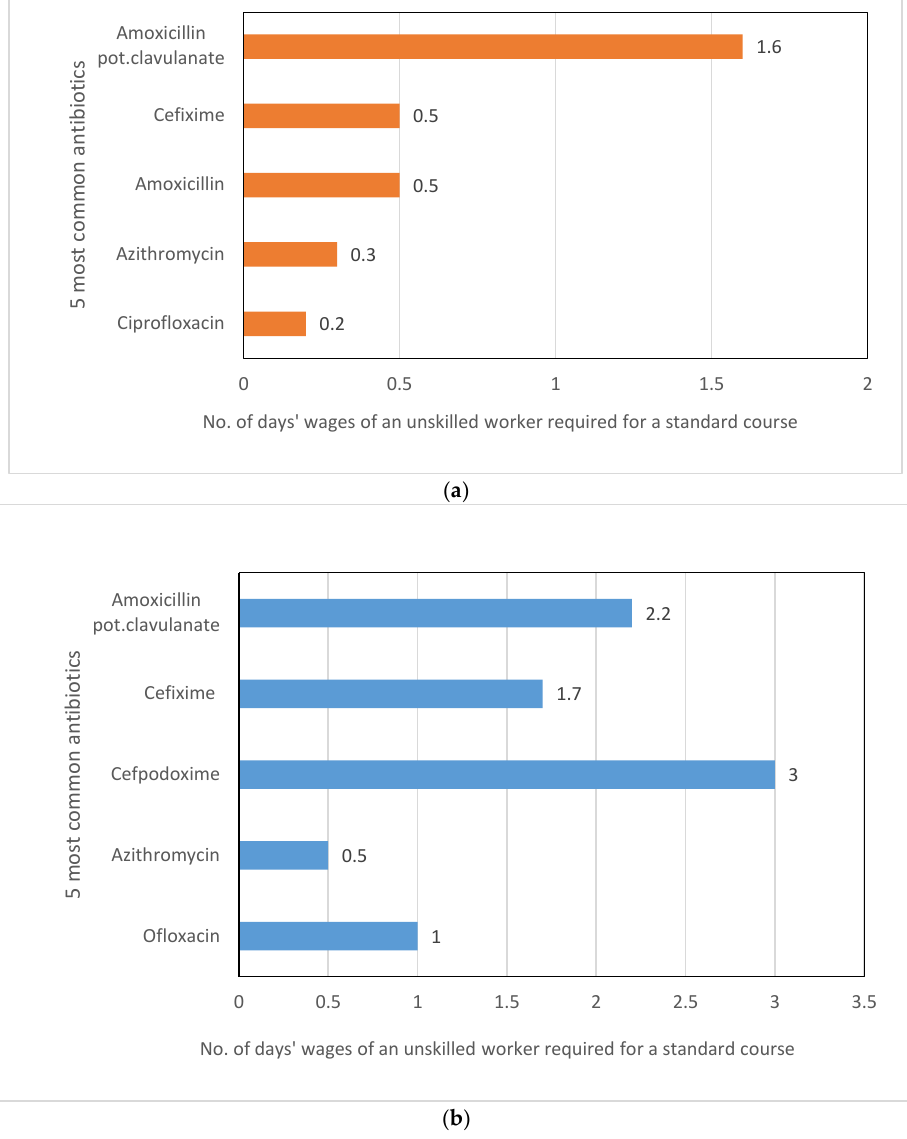
Figure 6. Number of days’ wages of an unskilled worker required to purchase a standard course of treatment for the five most commonly stocked antibiotics (across all brands), by formulation. ( a ) Tablets ( b ) Syrups/suspensions/drops.